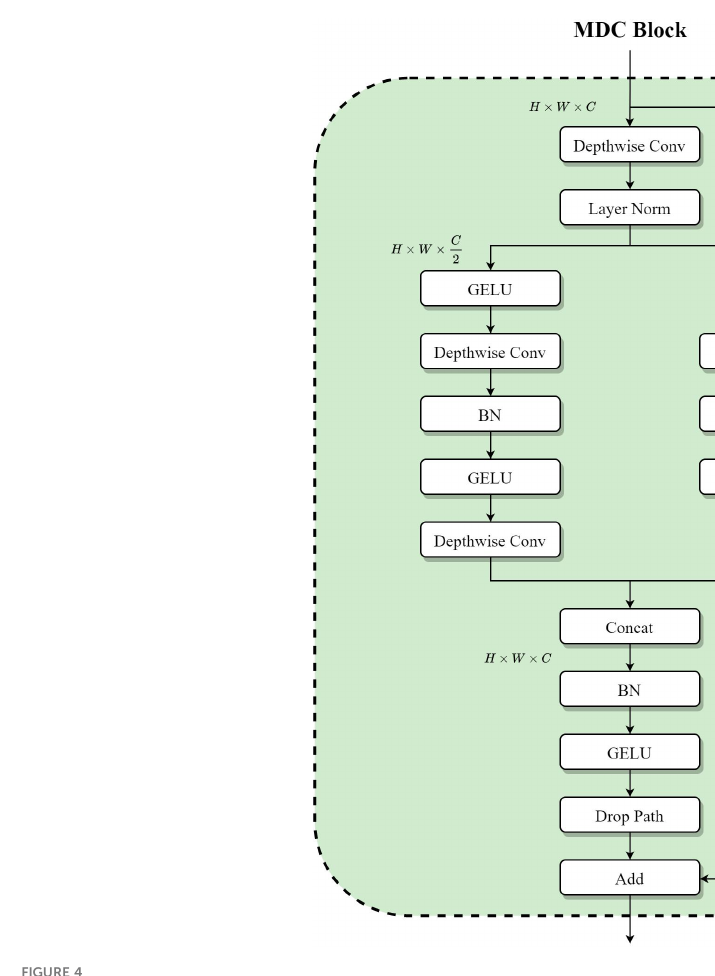
FIGURE 4 The structure of the MDC